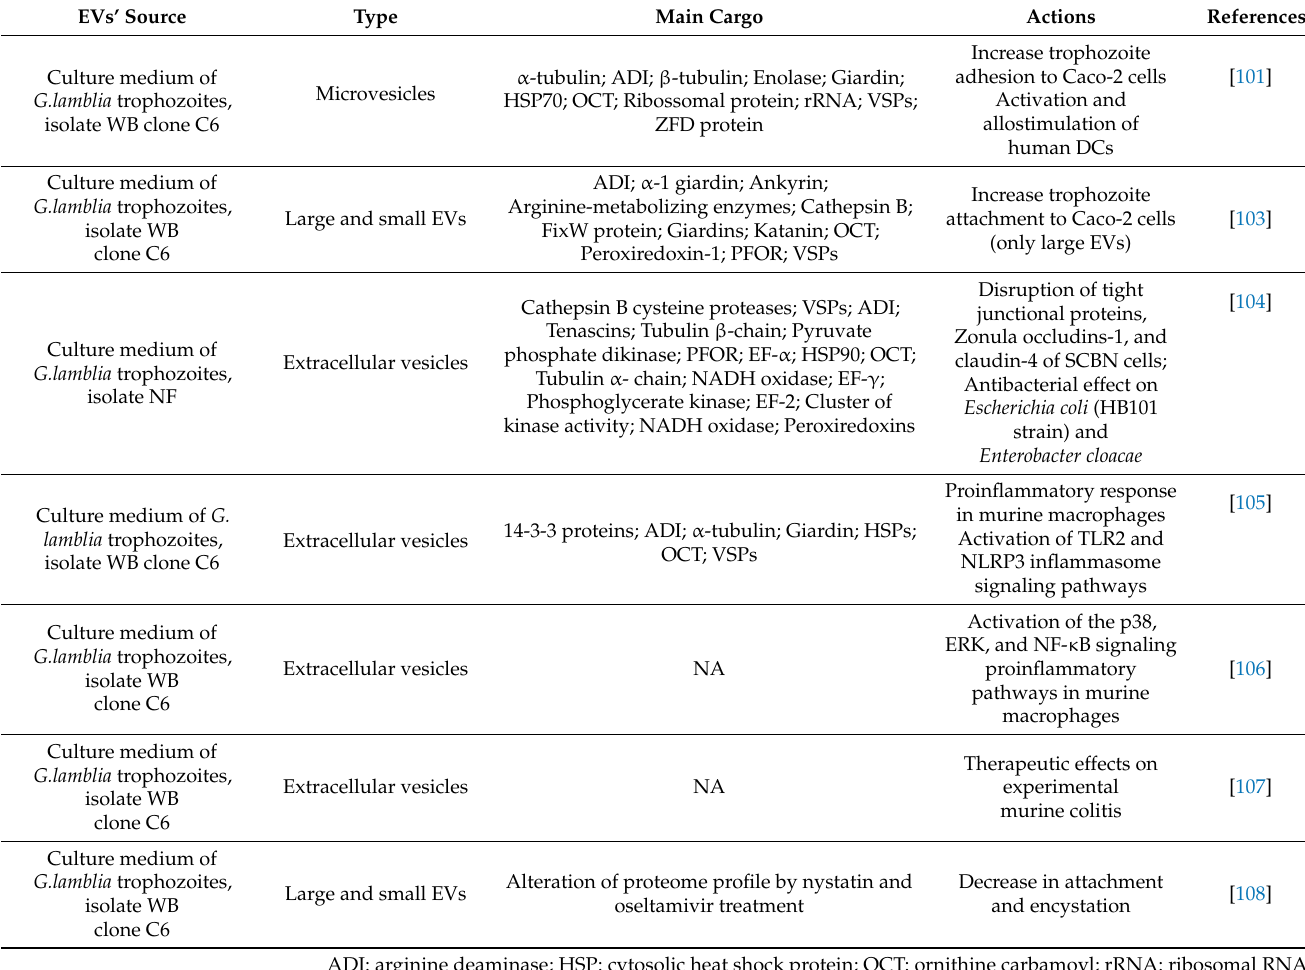
Table 2. Role of G. lamblia extracellular vesicles in host